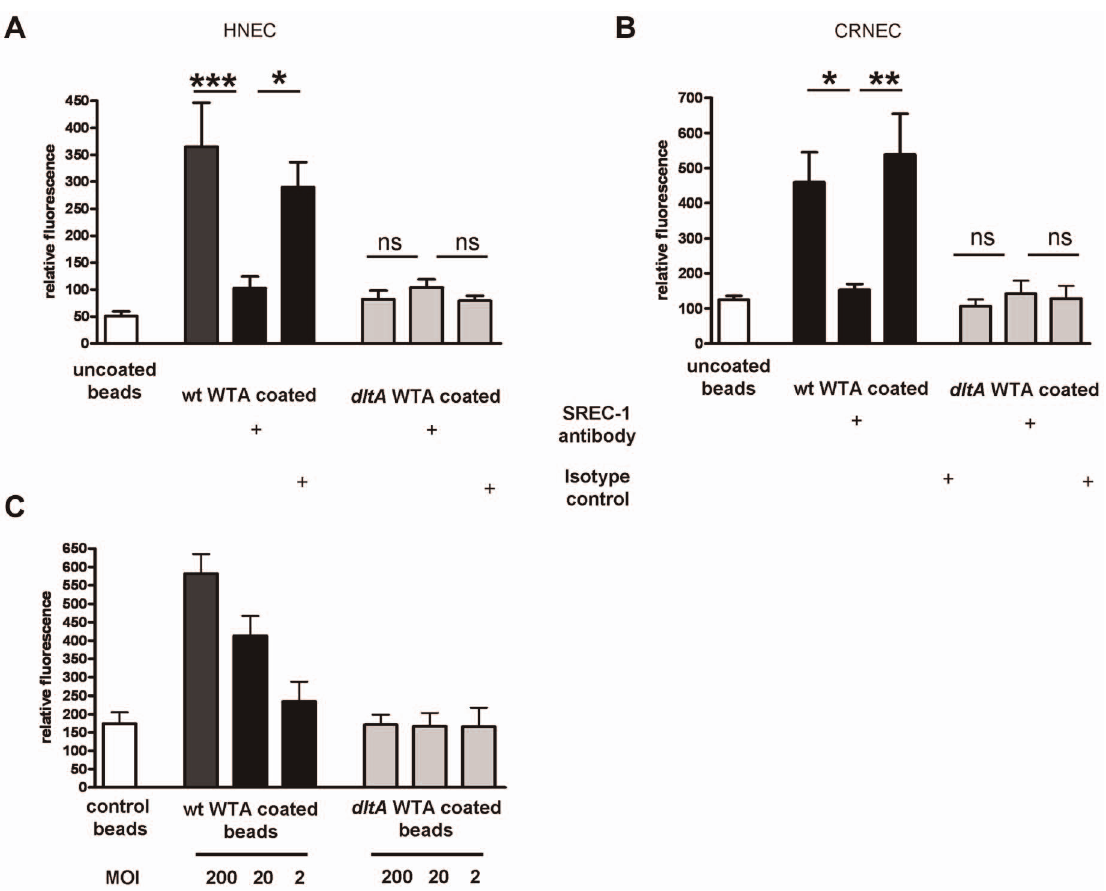
Figure 5. Impact of SREC-I on WTA-mediated adhesion to HNECs and CRNECs. The anti-human SREC-I antibody was used to test the influence of SREC-I on adhesion of WTA-coated latex beads under static condition in a 24 well microtiter plate assays on HNECs (A) and CRNECs (B). A ratio of 20 beads per epithelial cells was used in all depicted assays. 10 m g/ml of the anti-SREC-I antibody and isotype control were used to test the impact of SREC-I. Adhesion of the beads coated with wt WTA (HNECs and CRNECs) and dltA WTA (HNECs only) or control beads containing no WTA (HNECs and CRNECs) was measured in a fluoreader and expressed as relative fluorescence. The data are expressed as the means and SEM of 6 independent experiments. Statistical analysis was performed by one-way ANOVA with Bonferroni’s multiple comparison test (A and B). The dose dependency of WTA-coated latex beads was tested in assays with CRNECs (C). Adhesion of the beads coated with wt WTA and dltA WTA or control beads containing no WTA was measured in a fluoreader and expressed as relative fluorescence. The data are expressed as the means and SEM of 5 independent experiments (C). Significant differences between groups are indicated by one ( P , 0.05), two ( P , 0.01), or three ( P , 0.001) asterisks ( * ).